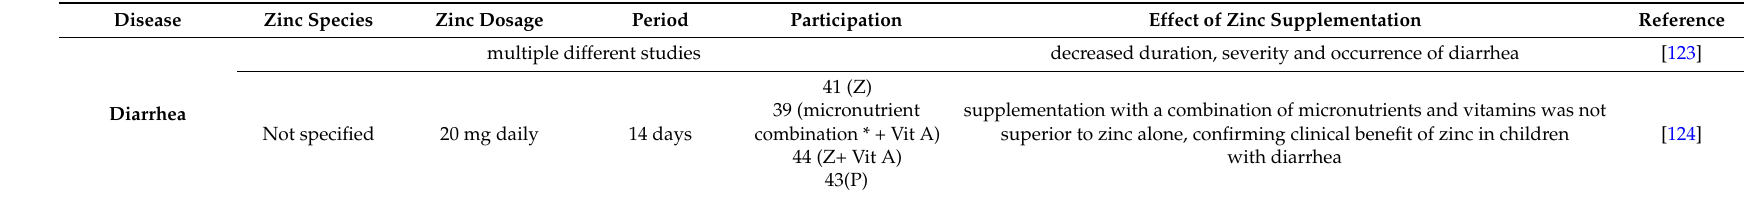
Table 2. Zinc supplementation and bacterial infectious diseases (updated from